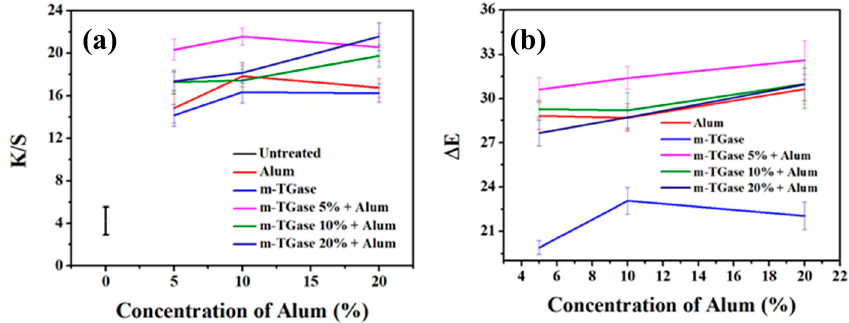
ff erence ( ∆ E) of untreated and treated Figure 5. ( a ) Color strength and ( b ) Color difference ( Δ E) of untreated and treated wool. Figure 5. ( a ) Color strength and ( b ) Color di